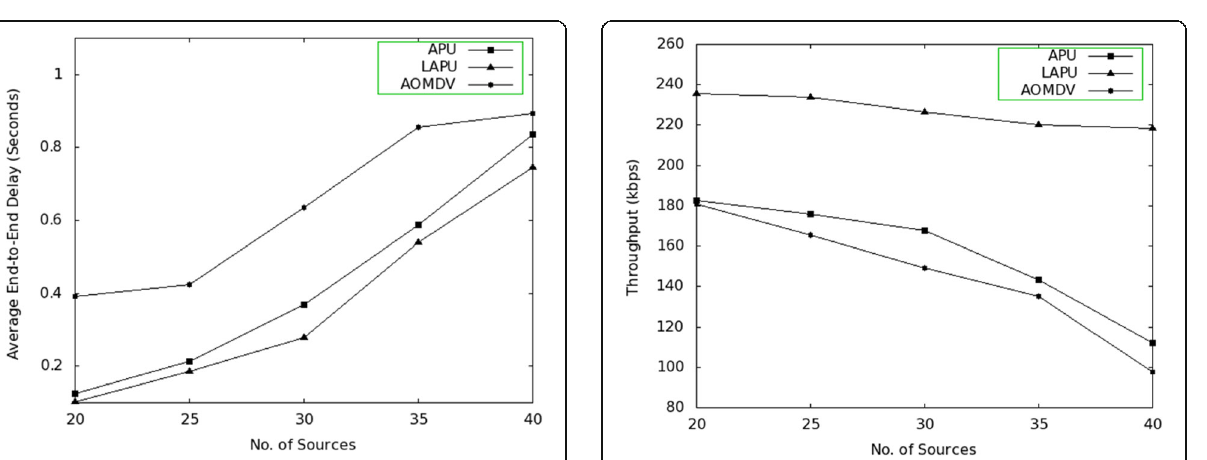
Fig. 11 Throughput vs. number of sources